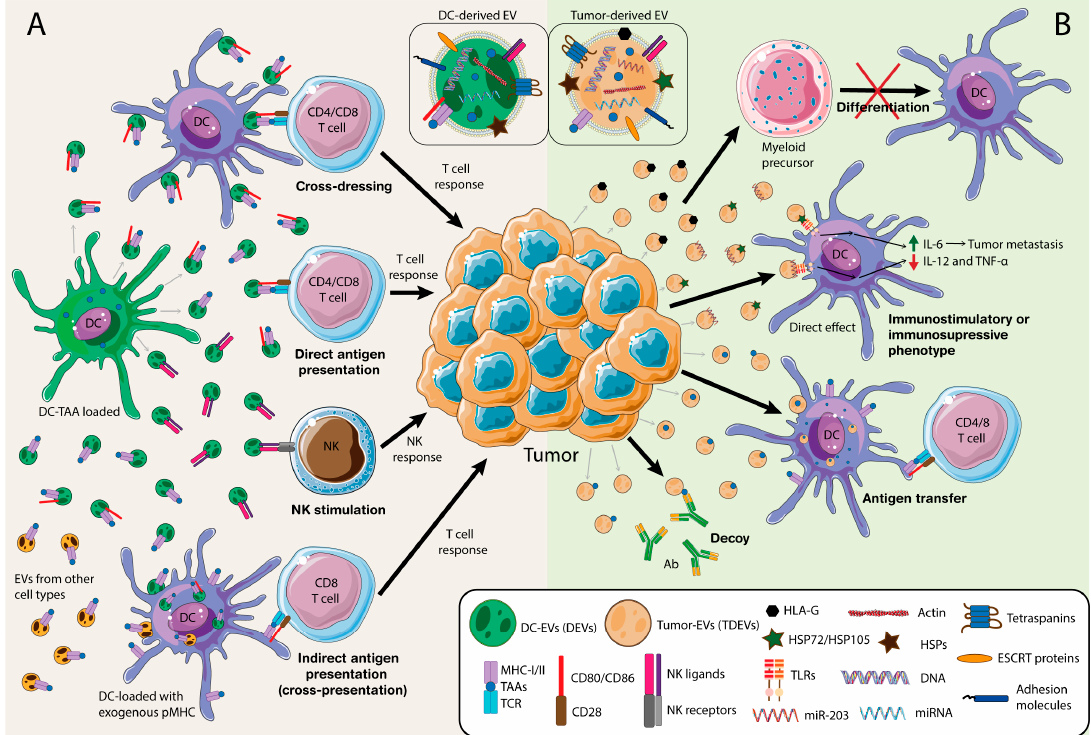
Figure 1. The role of extracellular vesicles (EVs) in dendritic cell (DC)-tumor cell interactions. ( A ) DCs carrying tumor-associated antigens (TAAs) produce Dendritic cells (DCs)-derived EVs (DEVs) that convey a variety of molecules. Particularly, DEVs are characterized by TAA-loaded major histocompatibility complex (MHC)-I/II and co-stimulatory molecules. These vesicles can coat other DCs, a process known as cross-dressing, or can directly interact with T cells, both processes leading to antigen presentation to CD4 + or CD8 + T cells. DCs, that did or did not contact the tumor before, can also incorporate TAA-loaded-DEVs and mediate antigen presentation to CD8 + T cells, called cross-presentation. Moreover, DEVs carry natural killer (NK) ligands on their surface, promoting NK stimulation and helping the immune antitumor response. ( B ) Tumors produce EVs (TDEVs) bearing TAAs, MHC-I/II and many other molecules. These TDEVs can interfere DC differentiation towards myeloid-derived suppressor cells (MDSCs). Moreover, specific molecules in these EVs can be recognized by toll-like receptors (TLRs) on the DC triggering a signaling cascade that ultimately leads to tumor metastasis or downregulates cytokine production. TDEVs bearing TAAs could be uptaken by DCs and are subsequently presented to T cells. Lastly, TDEVs can modulate other immune responses, like sequestering Ab on their surface, acting as decoys instead of coating the malignant cell. HSPs, heat shock proteins; HLA-G, non-classical human leukocyte antigen-G; ESCRT, endosomal sorting complexes required for transport; TCR, T cell receptor; miR-203, microRNA-203; and miRNA,